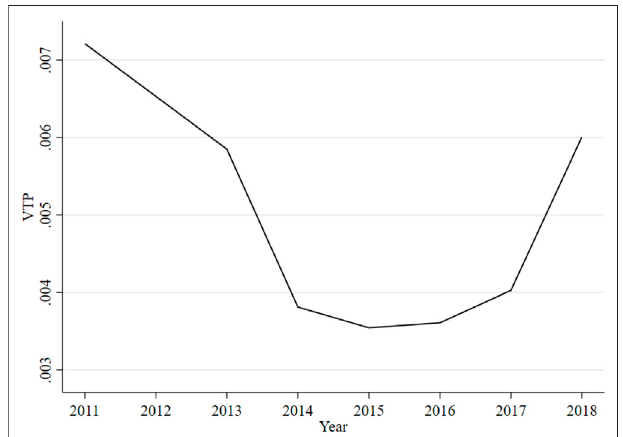
FIGURE 2 | The trend of average provincial volatility of technological progress in 2011 –